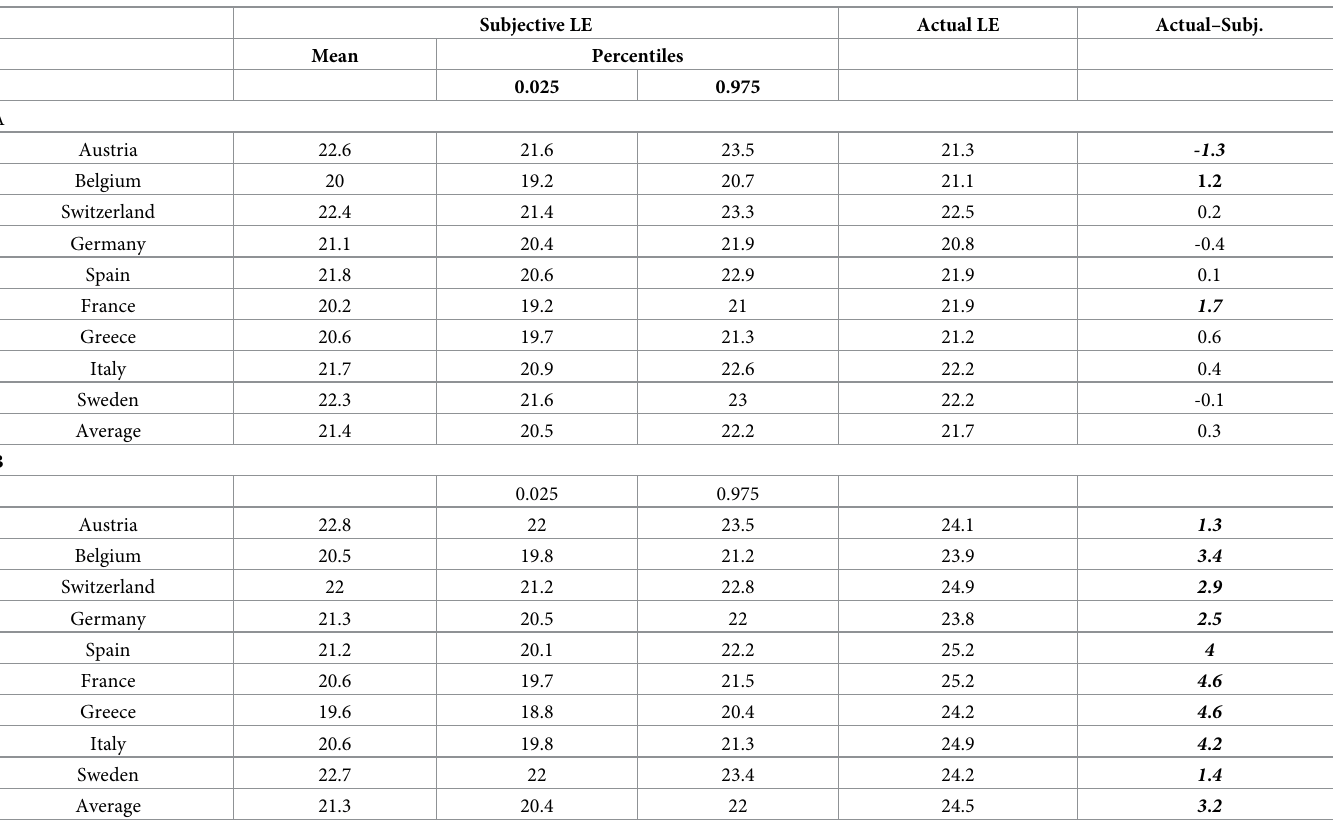
Table 4. a) Segmented subjective and actual life expectancy (LE) and percentiles of the subjective LE, males, 9 European countries, 2015.